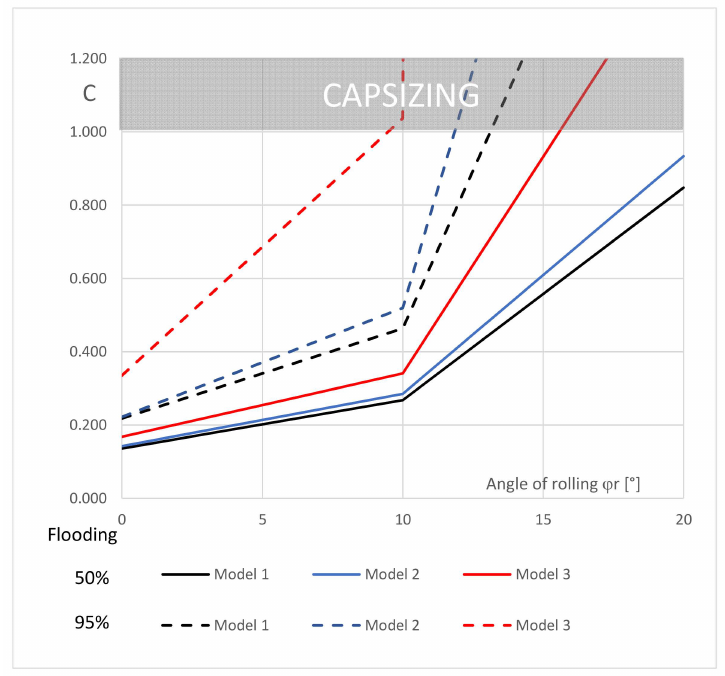
Figure 11. Values of the vessel’s capsizing coefficient (C) depending on its